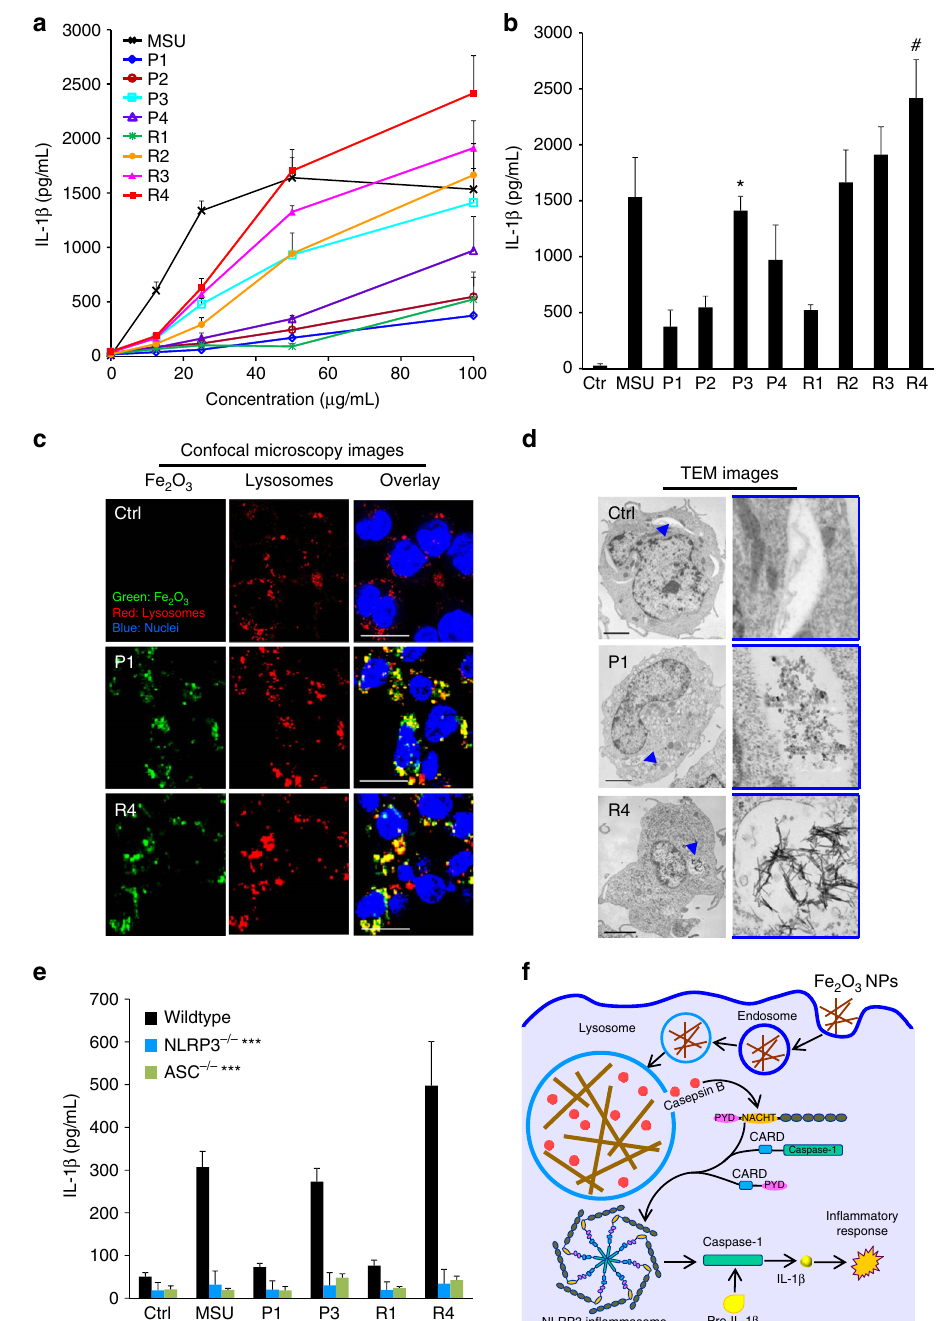
Fig. 4 Determination of the in fl ammatory pathway of Fe 2 O 3 in THP-1 cells. a Dose responses and b statistic comparisons of IL-1 β in THP-1 cells exposed to Fe 2 O 3 nanoparticles for 48 h. IL-1 β production in THP-1 cells exposed to 0 – 100 μ g/mL Fe 2 O 3 nanoparticles for 48 h. * p < 0.05 compared with P1, P2, and P4; # p < 0.05 compared with other particles (two-tailed Student ’ s t -test). After 48 h incubation of THP-1 cells with Fe 2 O 3 particles, the supernatants were collected to quantify cytokine productions by ELISA. Error bar represents SD, n = 3. c Confocal microscopy and d TEM imaging of internalized Fe 2 O 3 nanoparticles. THP-1 cells exposed to pristine or FITC-labeled Fe 2 O 3 nanoparticles were washed, fi xed, and stained for TEM or confocal microscopy imaging. Hoechst 33342 dye (blue) and Alexa Fluor 594-labeled antibodies (red) were used to identify nuclei and lysosomes, respectively. Scale bars for the TEM and confocal microscopy images are 5 μ m and 20 μ m, respectively. e Comparison of IL-1 β production in wild-type, NLRP3 − / − , and ASC − / − THP-1 cells exposed to Fe 2 O 3 nanoparticles, *** p < 0.001 compared with particle-treated wild-type cells (two-tailed Student ’ s t -test). Data in the line and bar graphs are shown as mean ± SD from four independent replicates. f Schematic to explain the in fl ammatory